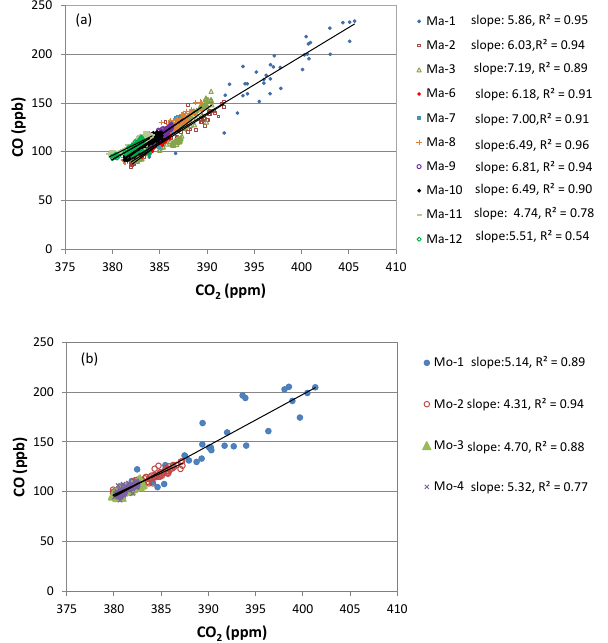
Fig. 4. Scatter plot of CO (ppb) versus CO 2 (ppm) from plume transects (a) Martin Lake (Ma-1 to Ma-12), and (b) Monticello (Mo-1 to Mo-4). The unit of the slopes from the least square fits is ppb/ppm.